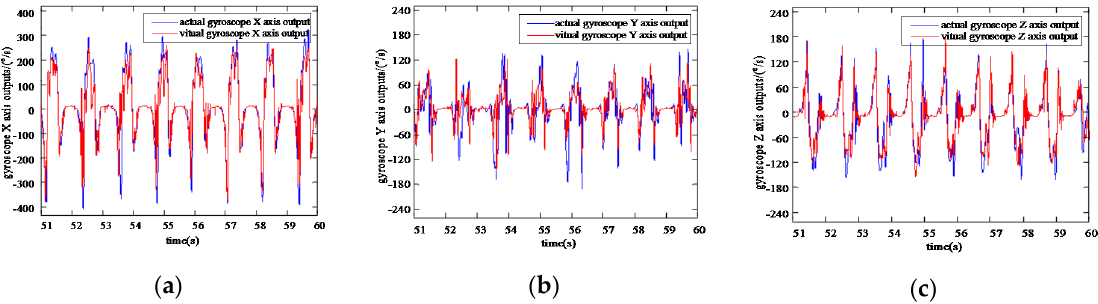
Figure 8. Information comparison of virtual gyroscope with reference gyroscope ( a ) Comparison of virtual gyroscope X axis information with reference gyroscope X axis information; ( b ) Comparison of virtual gyroscope Y axis information with reference gyroscope Y axis information; ( c ) Comparison of virtual gyroscope Z axis information with reference gyroscope Z axis information.